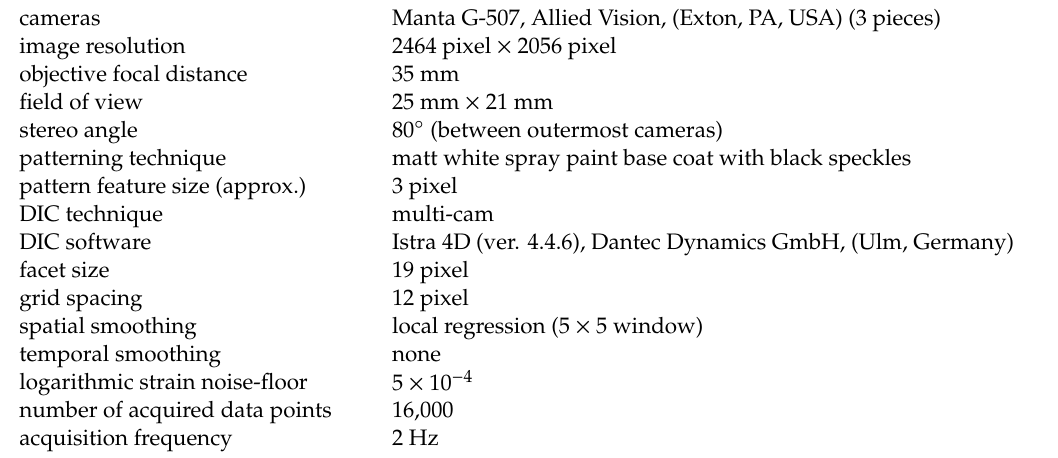
Table 1. Adopted Digital Image Correlation (DIC) settings for the heterogeneous